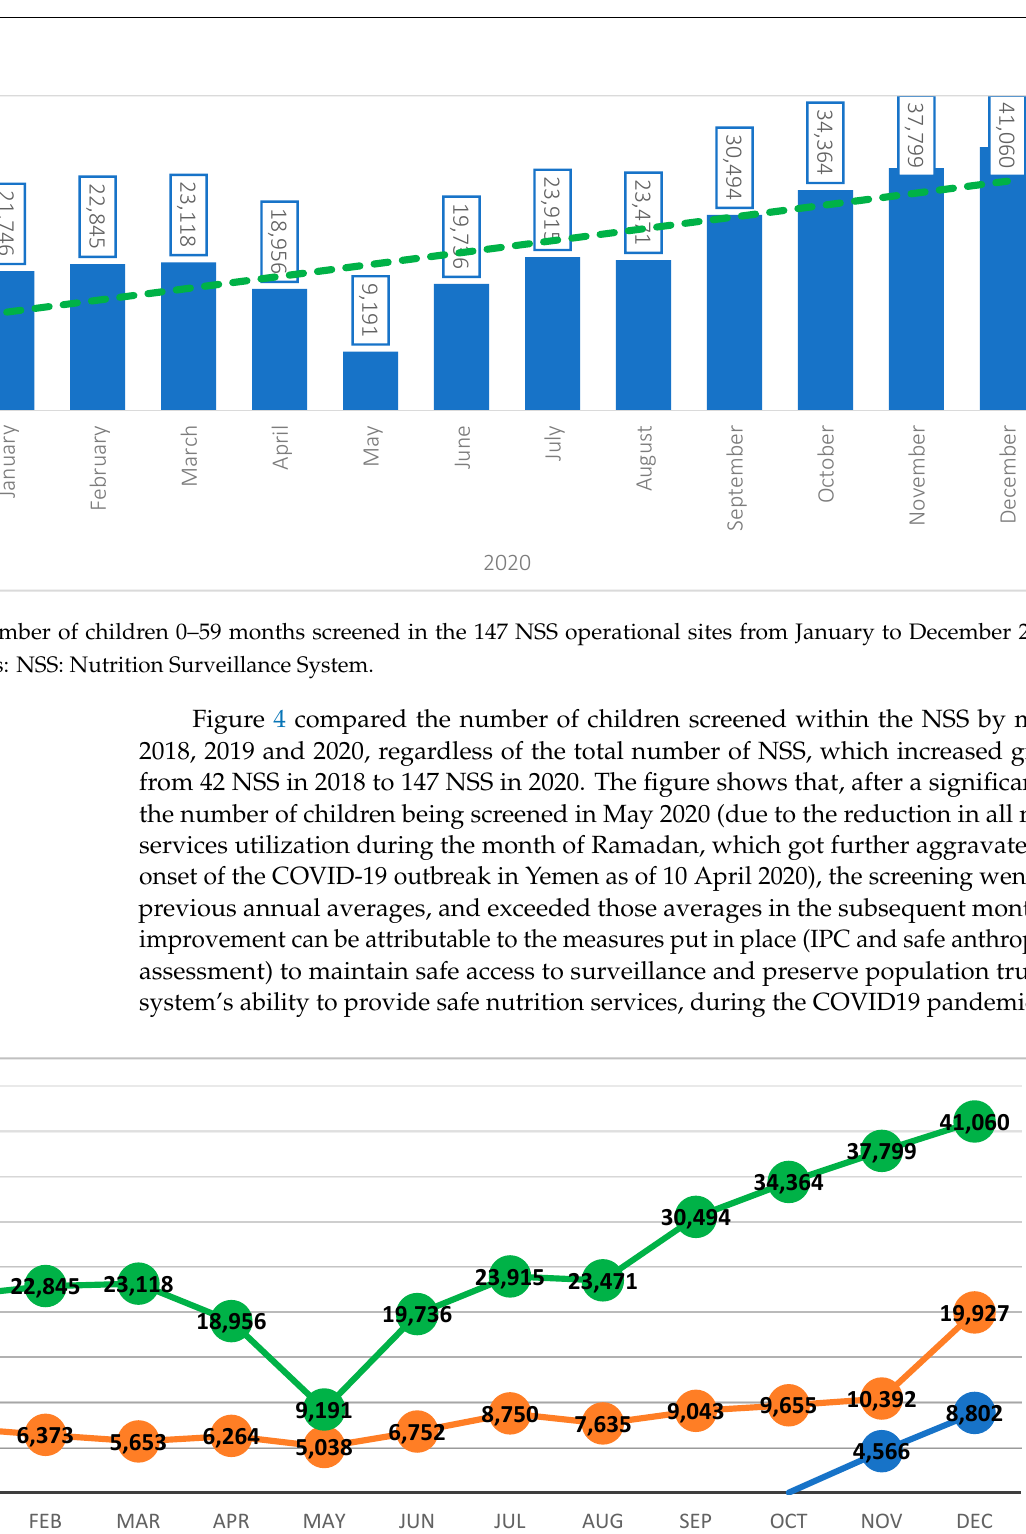
Figure 4. A comparison of the number of children screened within NSS by month in 2018, 2019 and up to December 2020. Abbreviations: NSS: Nutrition Surveillance System.